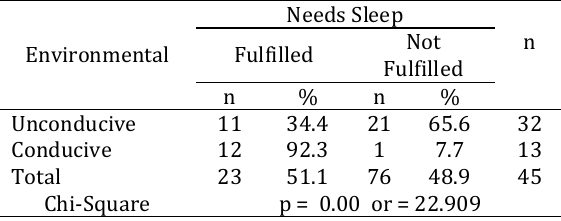
Table 2. The Results of the Analysis of the Relationship Between the Elderly Sleep Needs